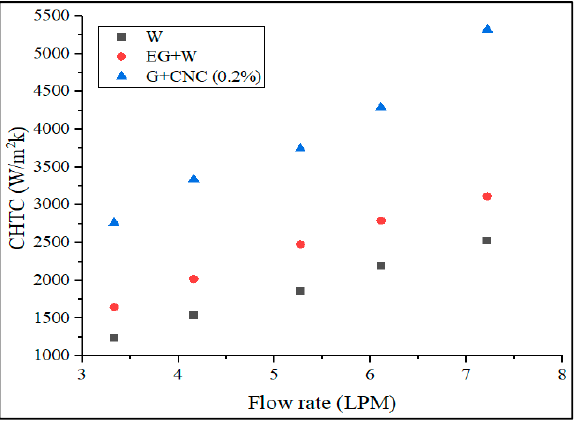
Figure 9. Convective heat transfer coefficient (CHTC) vs. flow rate in LPM.